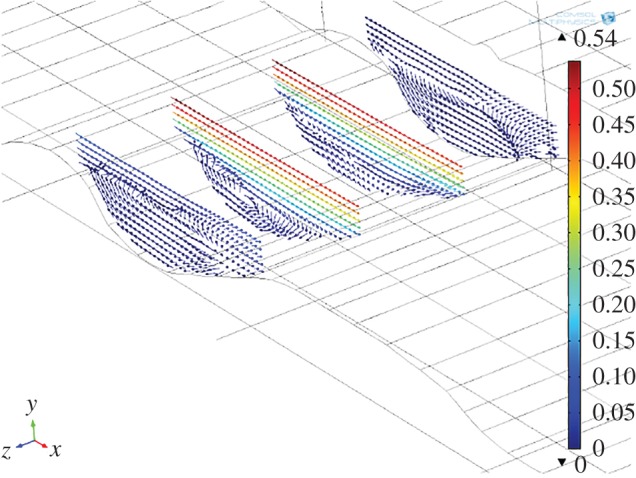
Three-dimensional simulation of eddy flow (without particles). Slices = volume velocity field (m s−1). Note velocity gradient in eddy rotation across the flow. Magma viscosity = 1 Pa s.